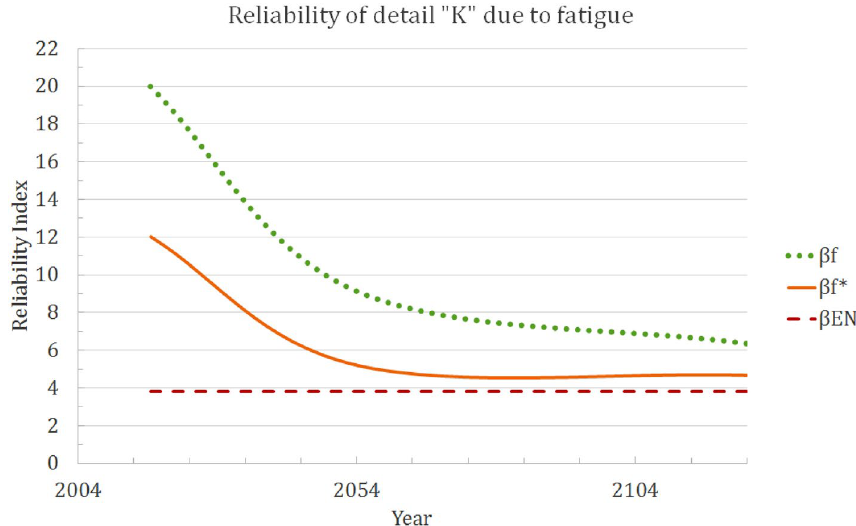
Fig. 15 Evaluation of reliability index with time, for